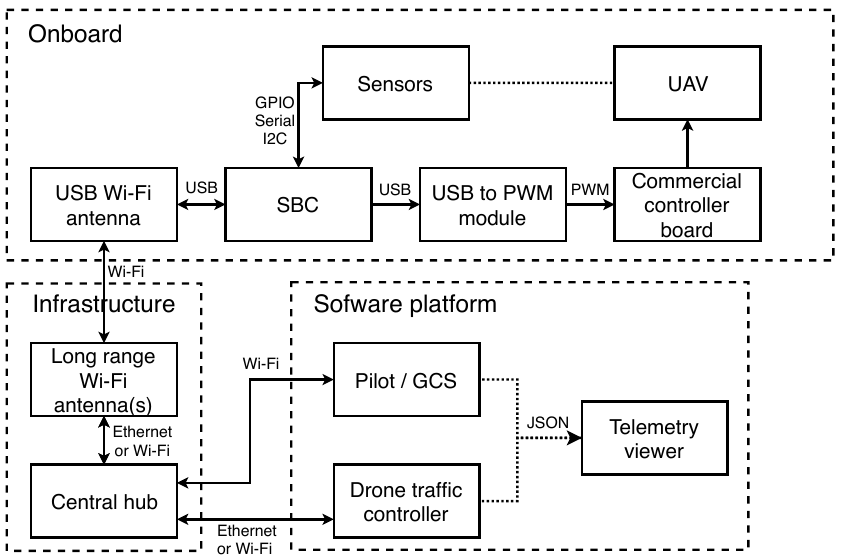
Figure 1. Global system connection diagram for a